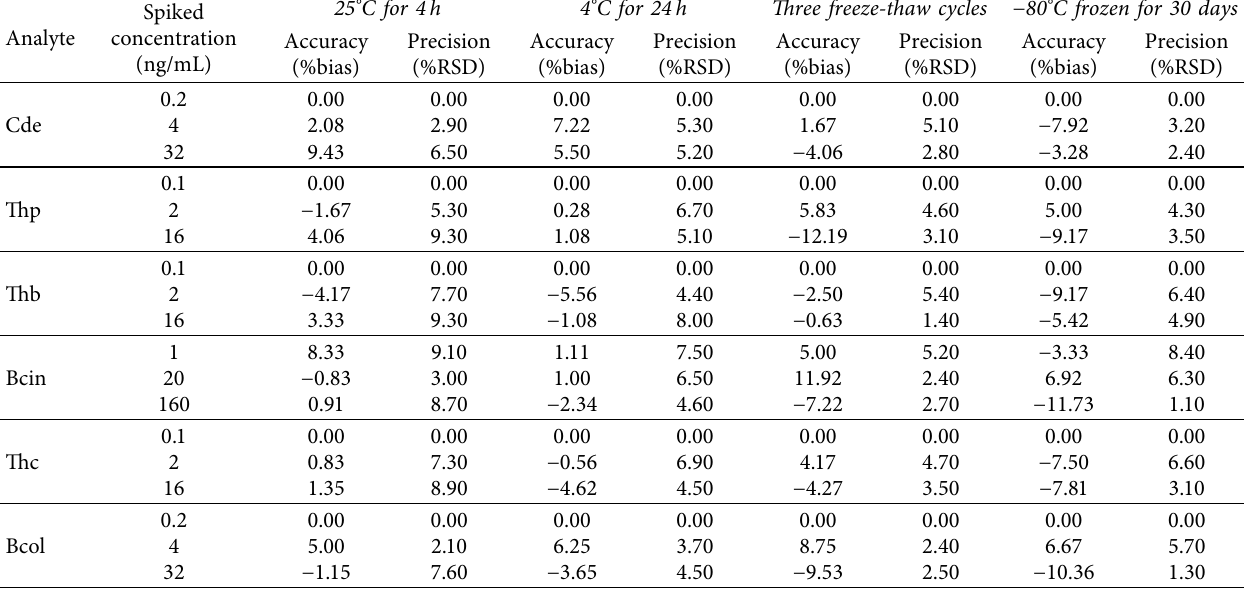
Table 7: Stability of the six analytes in dog plasma under different conditions (mean, n � 6). Analyte